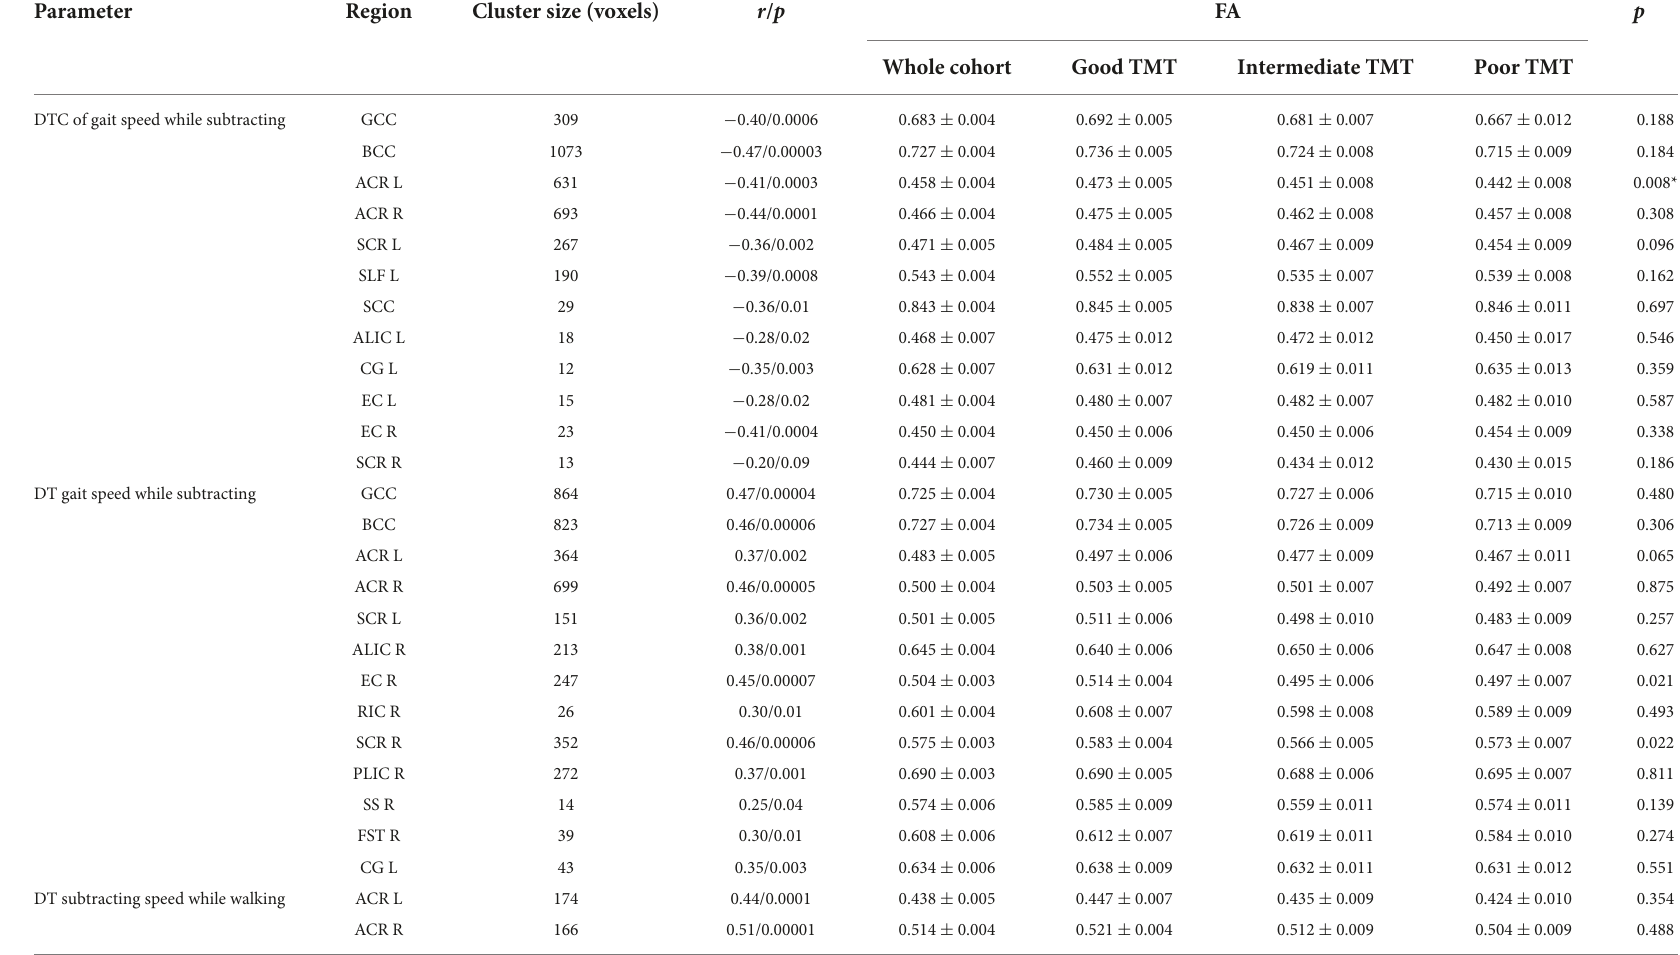
TABLE 3 Group differences in clusters with a significant partial correlation between dual-task parameters and FA adjusting for age, gender, and hypertension.